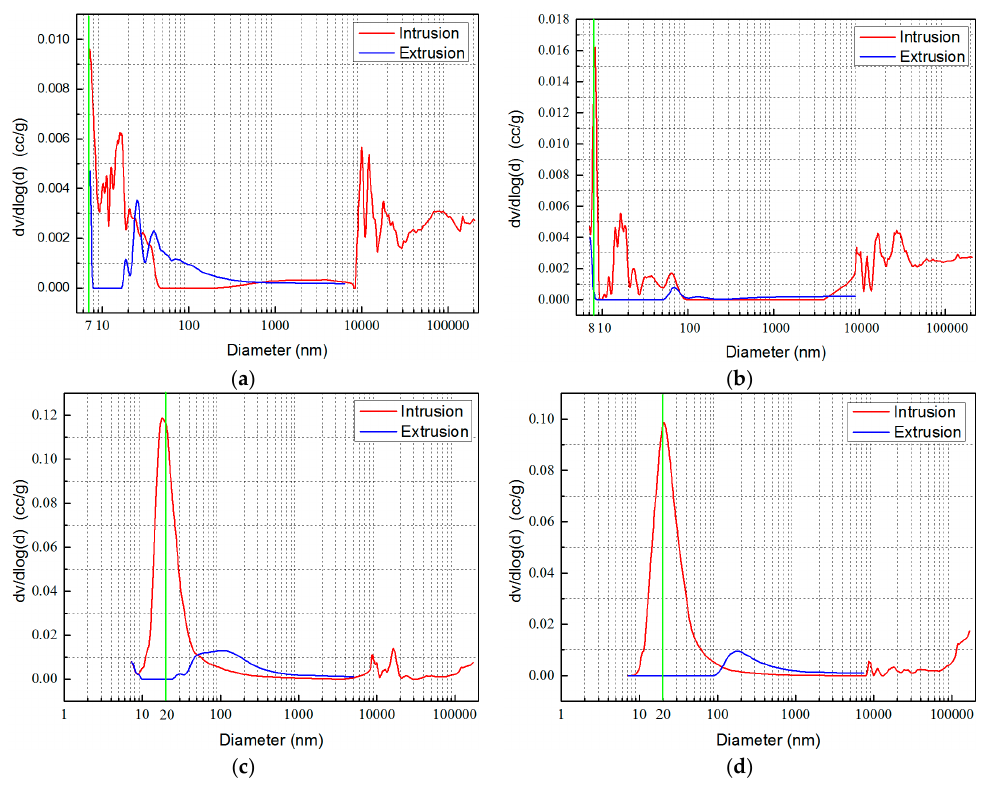
Figure 14. Pore size distribution. ( a ) Natural pure rock salt; ( b ) synthetic pure rock salt; ( c ) natural pure mudstone; ( d ) synthetic pure mudstone.